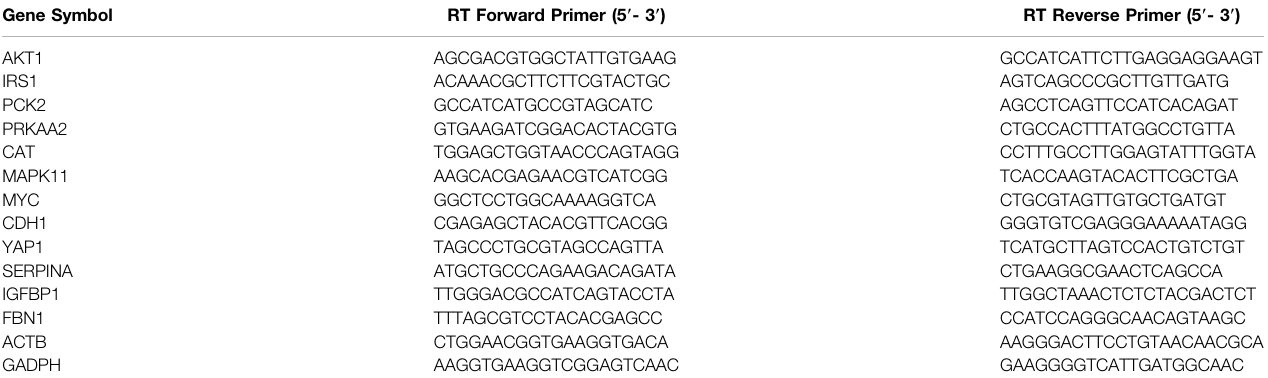
Table 1 | Sequences for gene primers. Gene Symbol